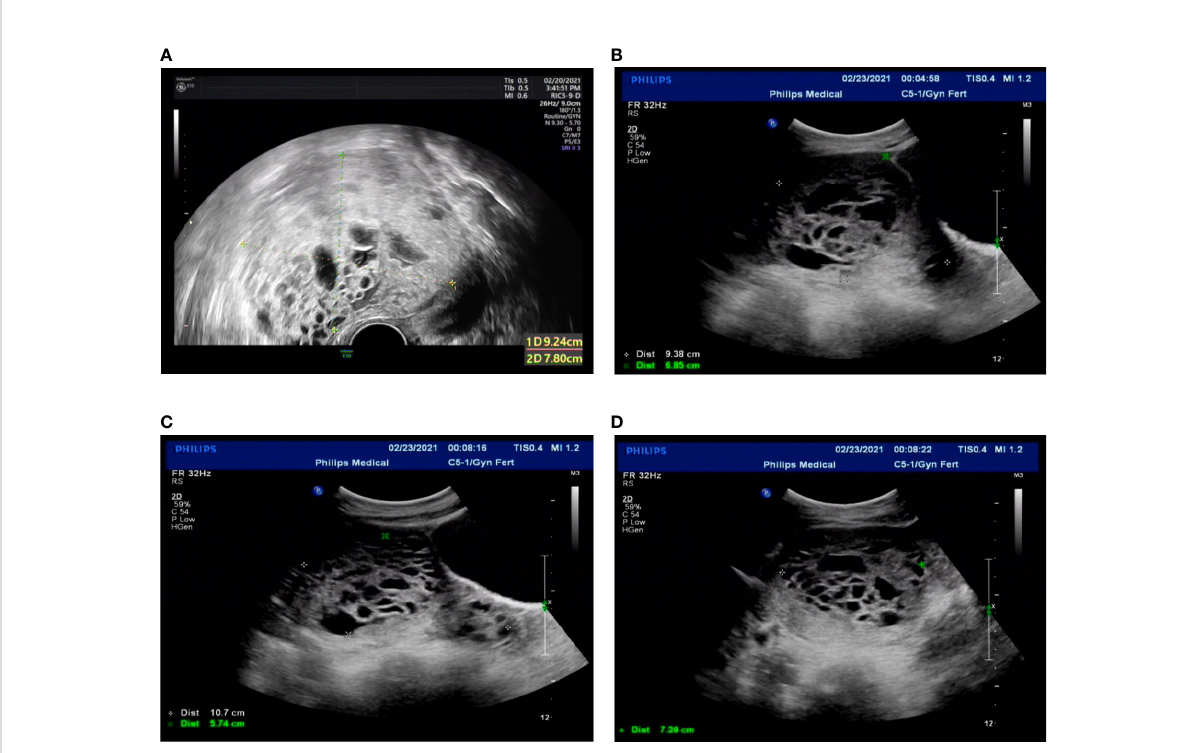
FIGURE 3 Transvaginal ultrasound. (A) Twenty-one days after the second molar evacuation. (B-D) The ultrasonographic image when the uterus perforation. The uterus was 9.4 × 9.7 × 6.9 cm, an uneven echo area of 10.7 × 7.1 × 5.7 cm was observed in uterine cavity and cervical canal, protruding left anterior wall, local muscle layer was unclear.